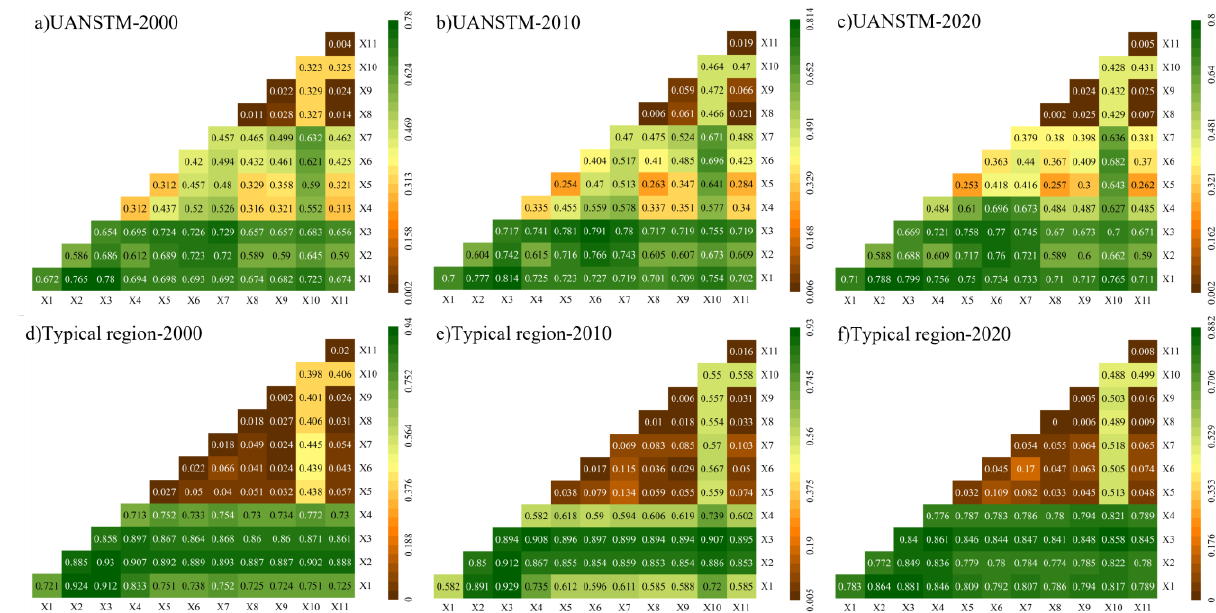
Figure 11. RSEI impact factors results of interaction detection.